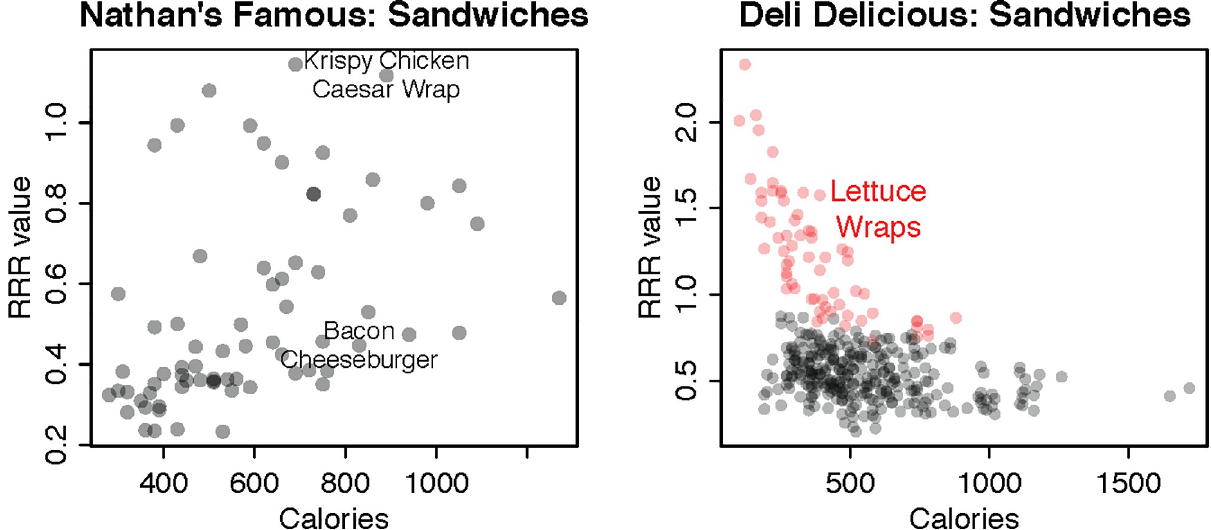
Fig 3. Illustration of relationship between calories and nutrient quality for sandwiches at Nathan’s Famous (left panel) and Deli Delicious (right panel).